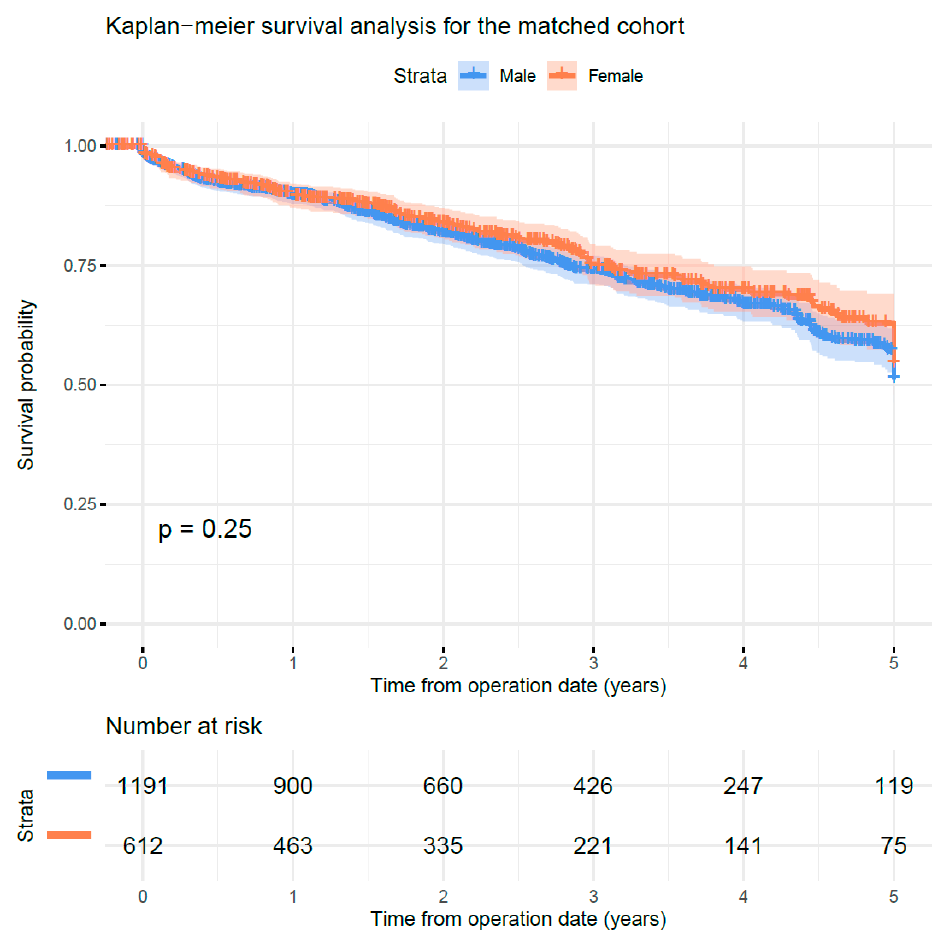
Figure 1. Kaplan–Meier survival analysis for this propensity score matched retrospective analysis of 1863 matched patients who underwent endovascular repair (EVAR) for intact abdominal aortic aneurysm between 2011 and 2017 by female vs. male sex. p -value for log rank test.